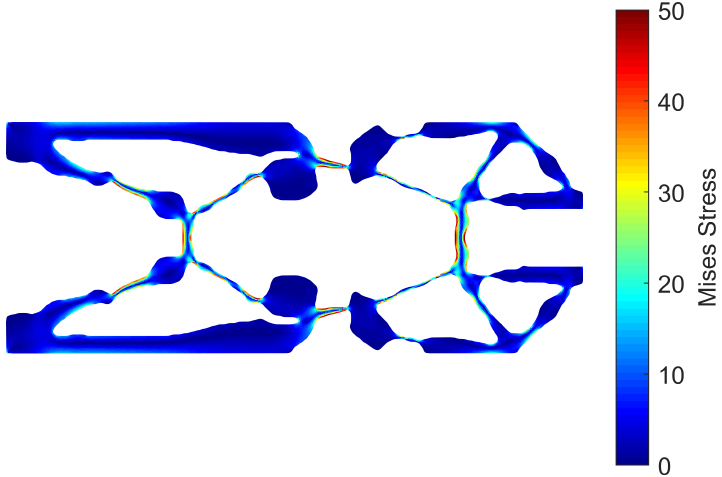
Figure 4. Stress field for gripper result based on Figure 3d with smoothed boundary (12,451 solid elements and 0 void elements) Table 3. Output displacement and maximum stress values for the gripper mechanism topologies in Figures 3 and 4